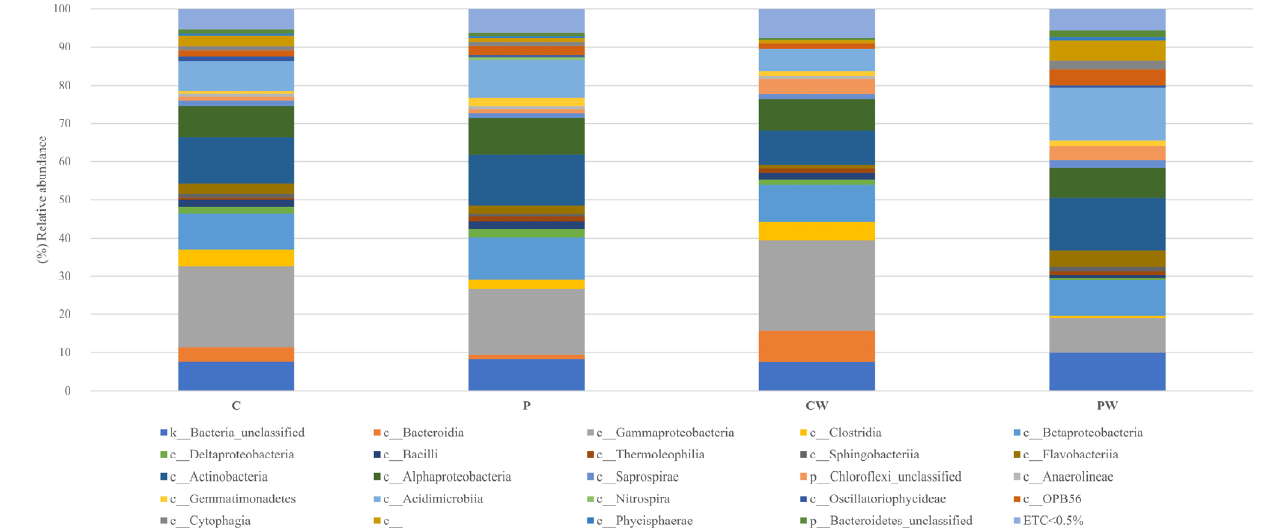
Figure 3. Relative abundance (%) of bacteria at class in the skin mucus microbiota of fish feed with control diet without (C) and with wound (CW); fish feed with probiotic diet without (P) and with wound (PW). ETC: relative abundance <0.5% in average; c__non taxonomy classify OTUs at this categorize.